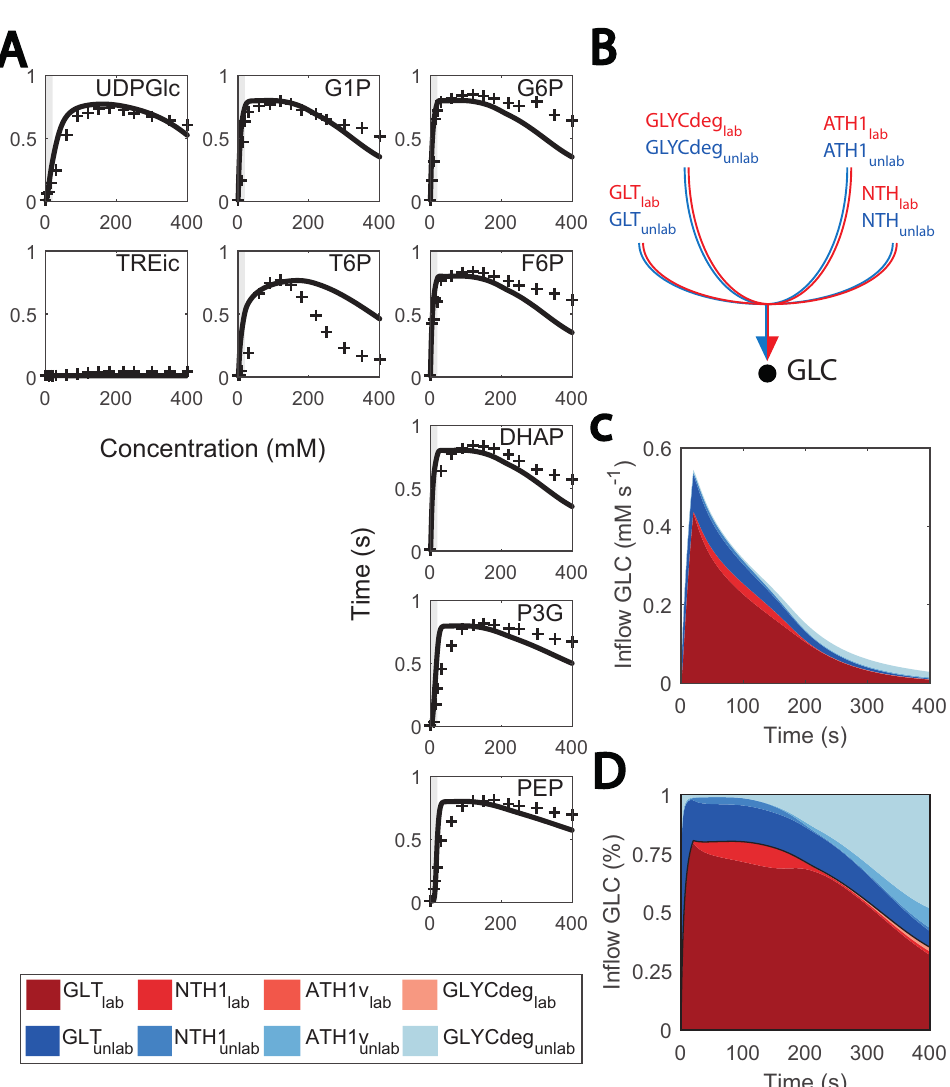
Figure 7. Predicted and observed 13C labelling enrichment during substrate perturbation cycles: ( A ) enrichment of intracellular metabolite (%) vs time; black lines consist of the simulations and red markers to the experimental data points. Feeding phase is shaded in grey. The X-axis is the cycle time, from 0 to 400 s, and the Y-axis is the enrichment percentage, from 0 to 100%; ( B ) diagram of inflow to cytosolic glucose; ( C ) fluxes that positively contribute to the cytosolic glucose mass balance (mM s − 1 ) vs. the cycle time (s); red coloured are labelled data, blue coloured, non-labelled; ( D ) contribution of each flux to the cytosolic glucose mass balance (in %) vs. the cycle time (s); red coloured are labelled data, blue coloured are